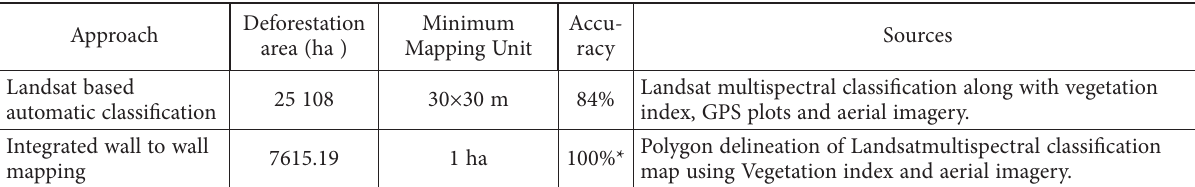
Table 2. Estimated deforestation areas using three different